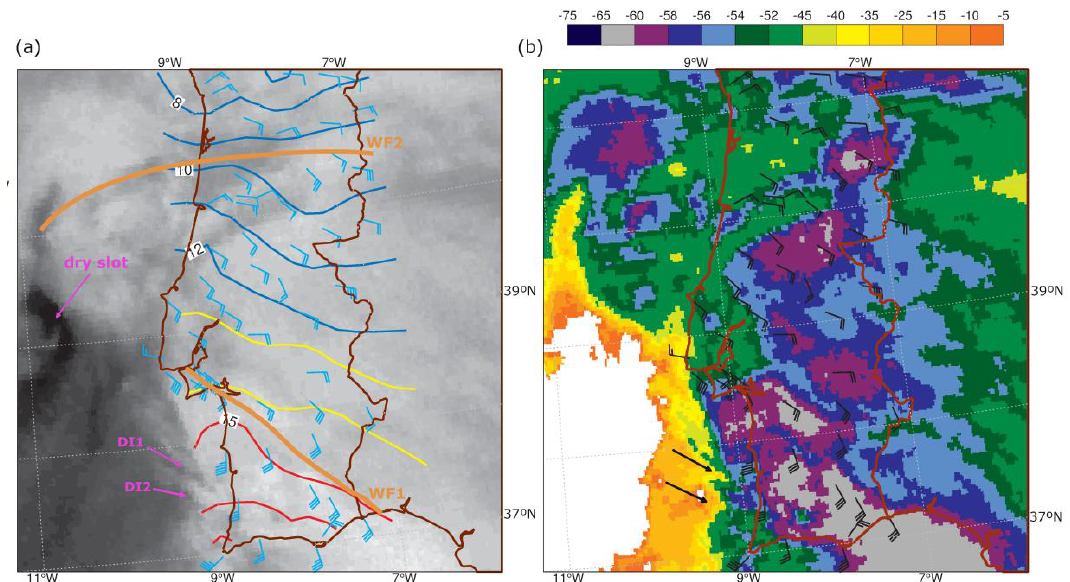
Figure 6. ( a ) MSG WV6.2 image superimposed with surface θ w (1 °C intervals, from 8 to 12 °C in blue, 13 and 14 °C in yellow lines and ≥15 °C in red lines) and wind gust at 10 m (barbs); ( b ) IR10.8 brightness temperature (shaded from −5 to −75 °C) superimposed with wind gust at 10 m at 02:30 UTC. The dry air finger patterns (DI1 and DI2), dry slot, and warm fronts WF1 and WF2 (orange lines), are marked in ( a ).